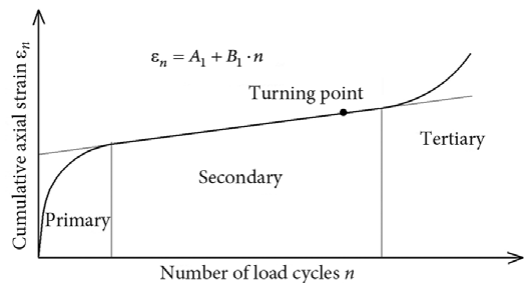
Fig. 1. The typical creep curve of asphalt mixtures according to EN 12697-25:2005 Bituminous Mixtures. Test Methods for Hot Mix Asphalt. Cyclic Compression